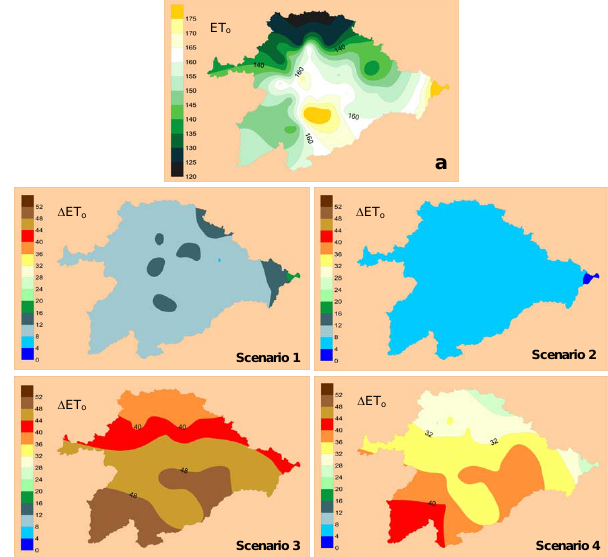
Fig. 3. (a) August ET o (mm) for reference year 2007 and increases ( 1 ET o , mm) by 50yr according to scenarios 1, 2, 3 and Fig. 3. a, August ET (mm) for reference year 2007 and increases ( Δ ET , mm) by 50 years according to Scenarios 1, 2, 3 and 4.